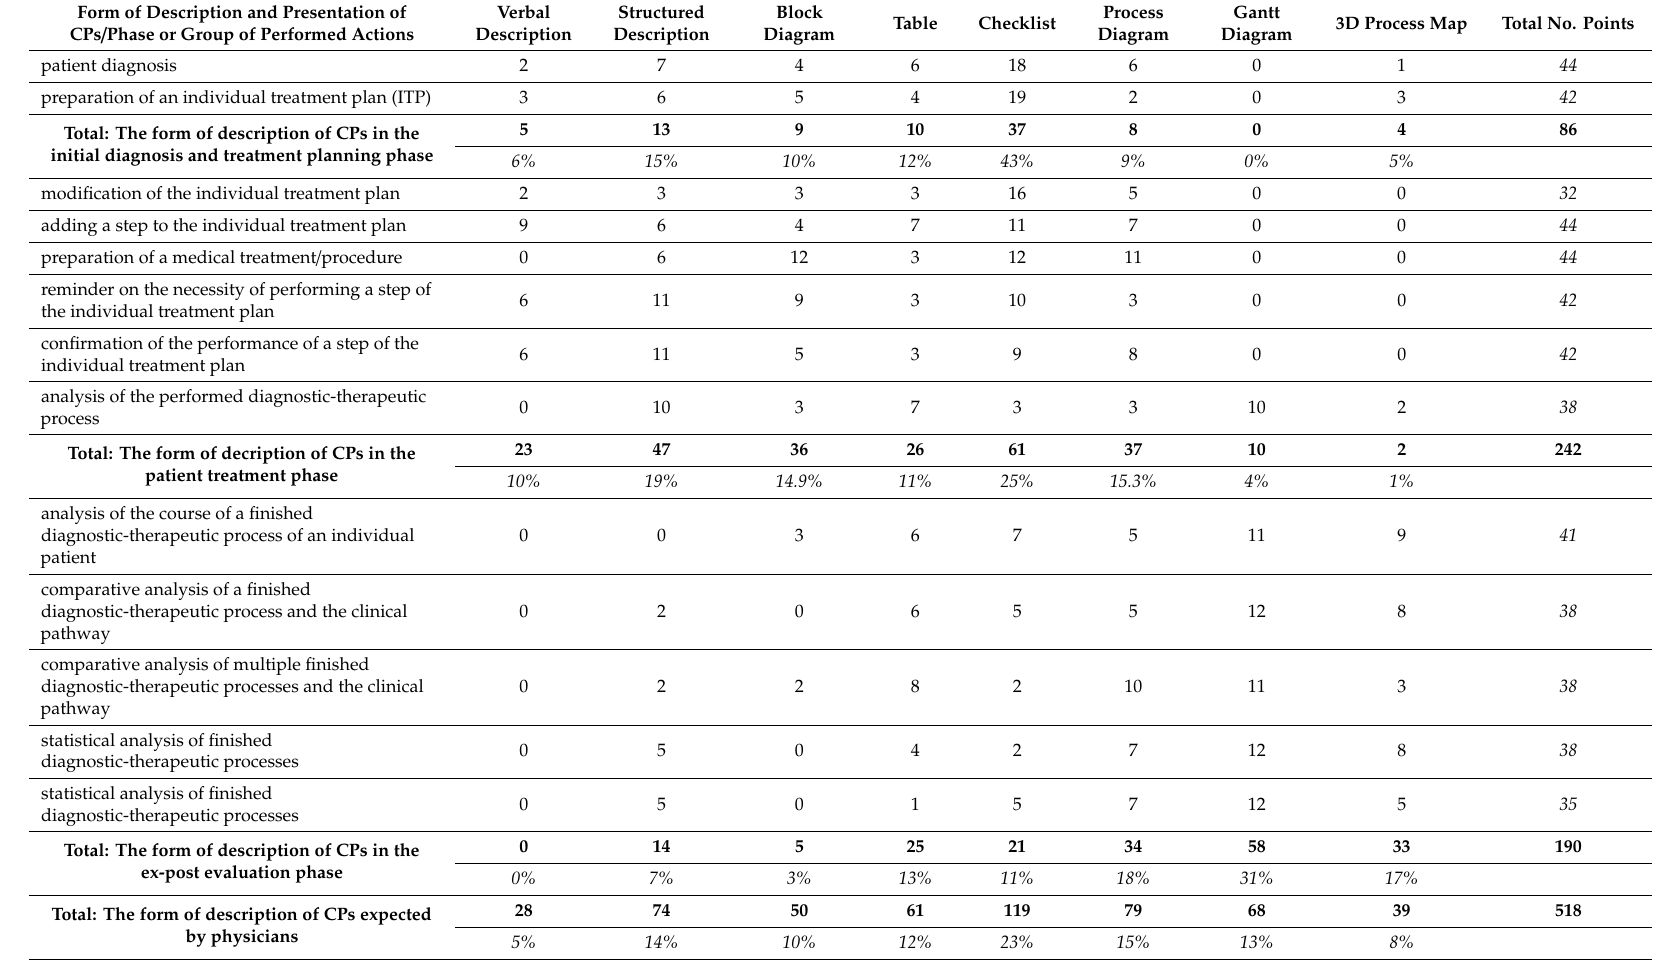
Table 2. Forms of description of CPs preferred by